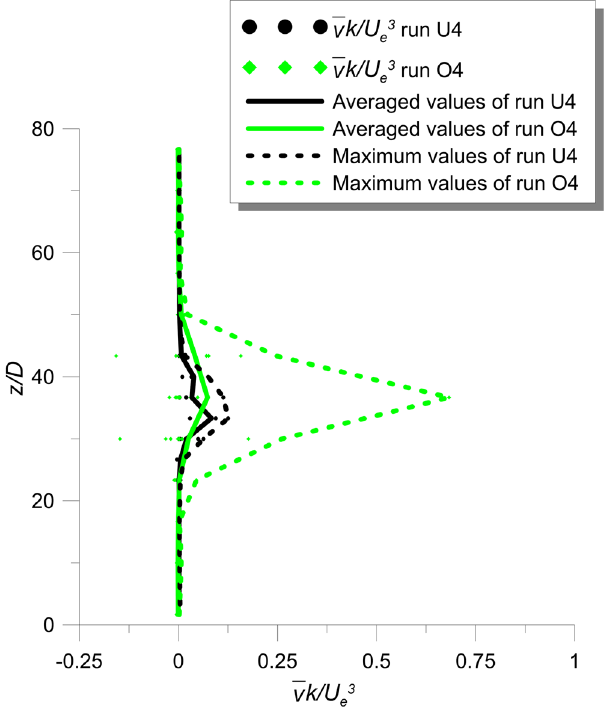
Figure 9. Values of vk of runs U4 and O4 of the transversal section at x / D = 26.67 with the lines of the averaged-values and the